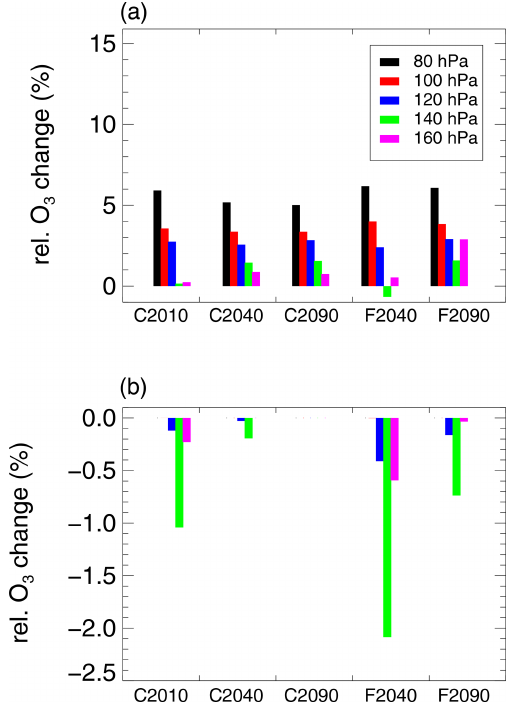
Figure 10. Relative chemical ozone change in the subtropical lati- tude band (30–35 ◦ N) in the mixing layer determined from the dif- ference between initial and final ozone for the 10-day CLaMS box- model simulations in the considered cases (see Table 1). The over- all ozone change (a) within single pressure levels between 70 and 300hPa (see Table 2) is shown as well as the ozone change from air masses in which chlorine activation can occur normalized by the to- tal initial ozone from all air masses in the GLENS mixing layer (b)